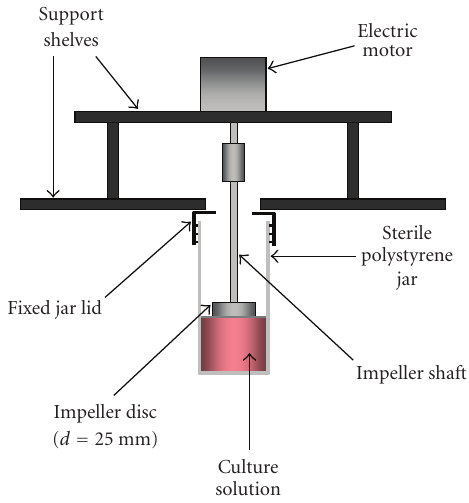
Figure 1: Schematic of the rotating disc bioreactor. Diagrammatic representation of the prototype rotating disc bioreactor rig designed for mammalian cell